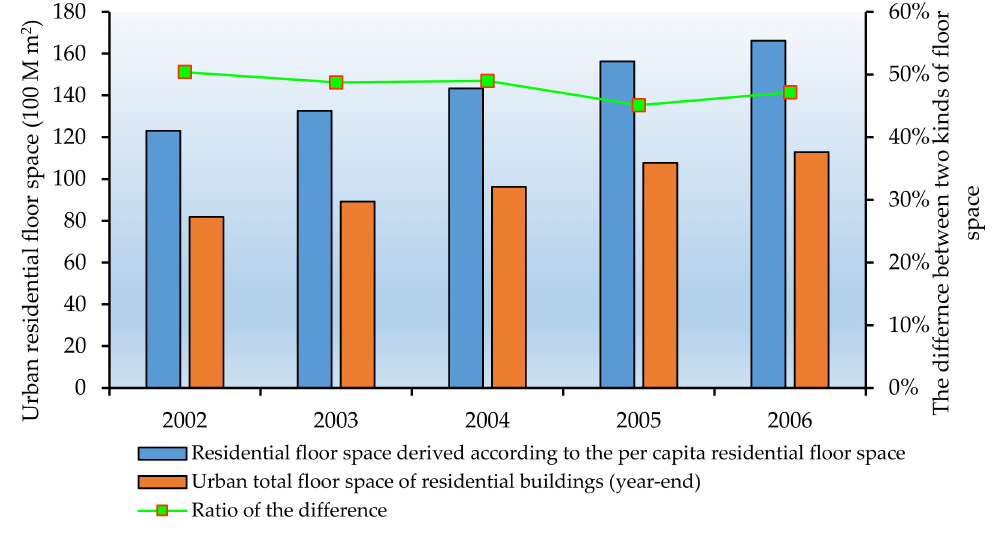
Figure 2. The comparison between the two calibers of the